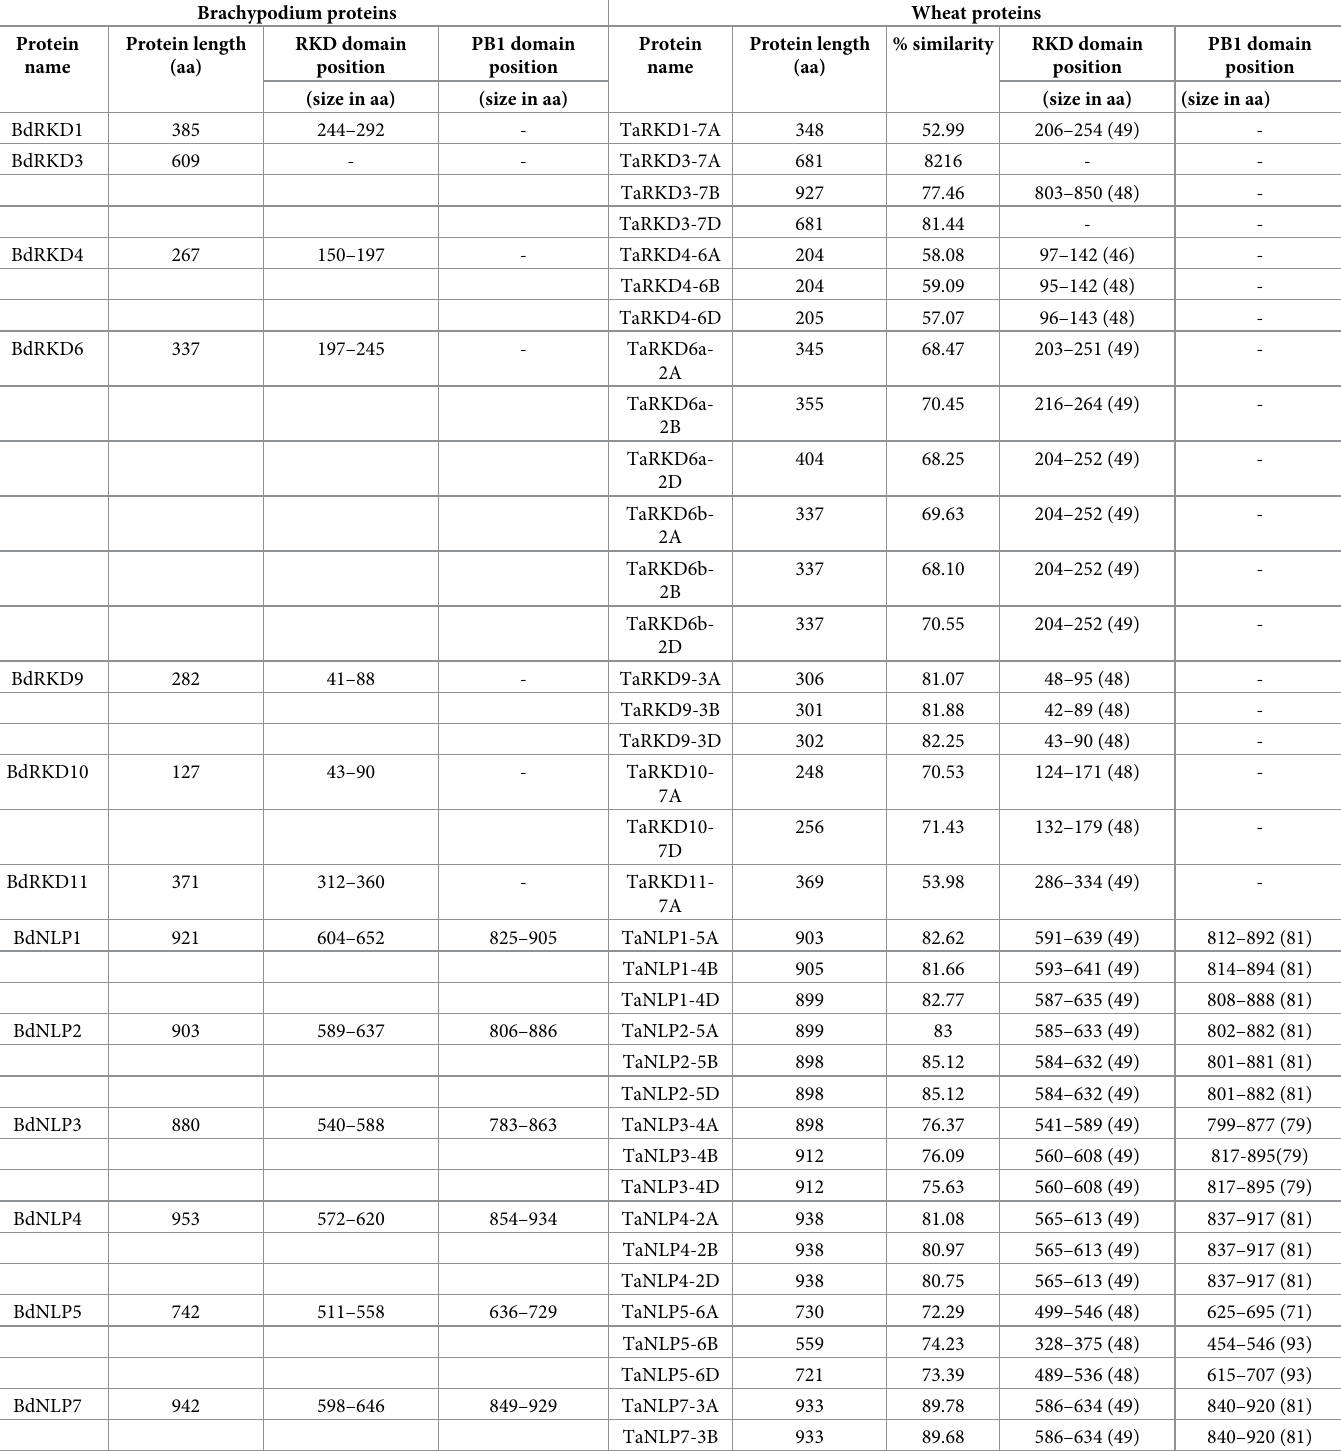
Table 5. Details of Brachypodium and wheat RWP-RK proteins sequences and their conserved domains (with per cent similarity of wheat proteins with Brachypo- dium